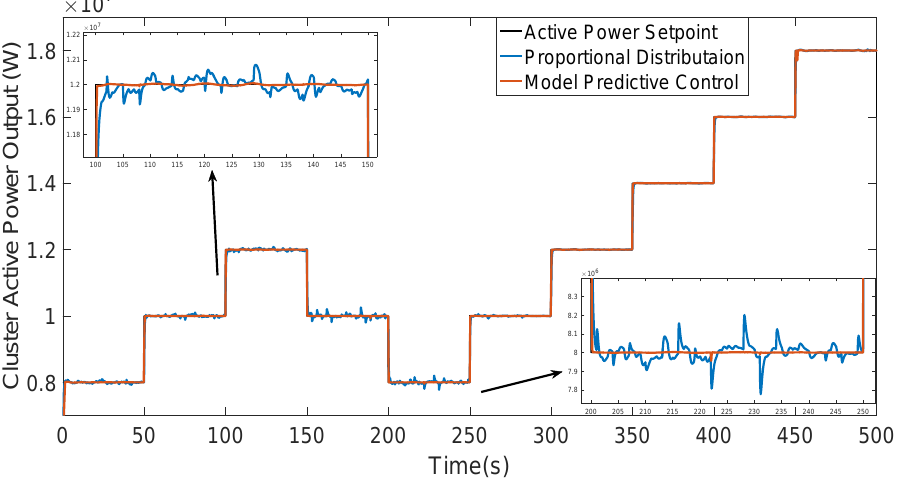
Figure 6. Four-units cluster robustness test—cluster power output (measured wind speed with Gaussian white